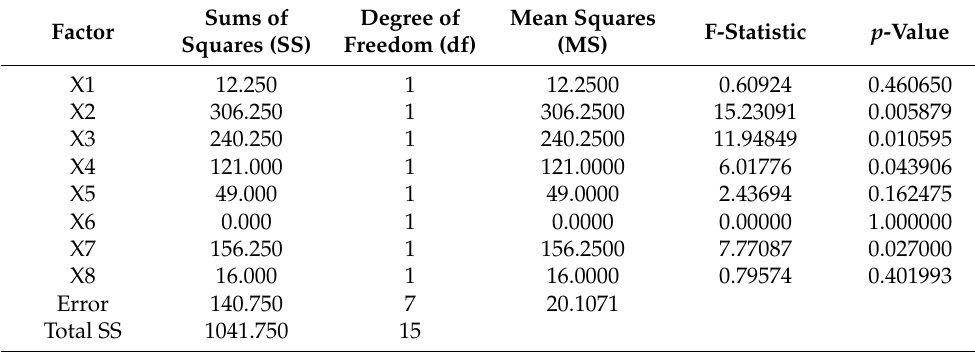
Table 2. Results of the analysis of variance (ANOVA) applied to data of percentage efficiency of oil and grease removal collected in tests carried out with the semi-industrial IPST according to the fractional factorial design.